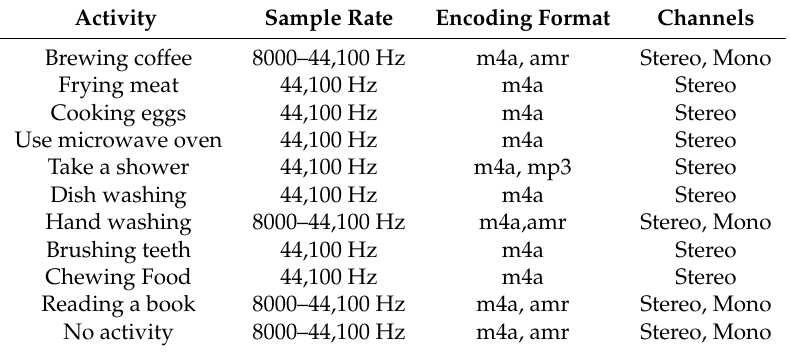
Table 3. Sounds meta-data per